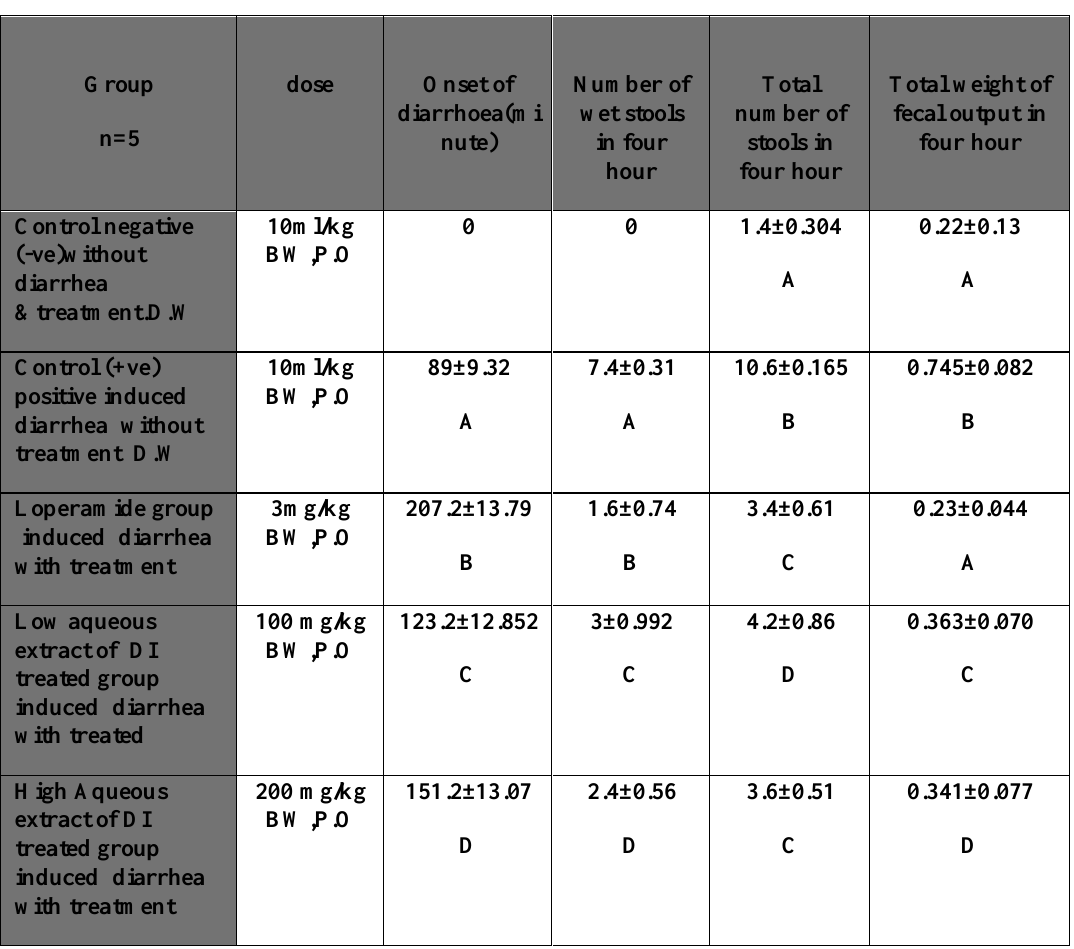
Table(2).Effect of aqueous extract of datura innoxia on magnesium sulphate induce diarrhoea in